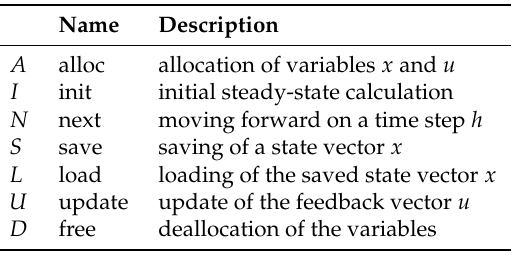
Table 2. Loose coupling interface functions.